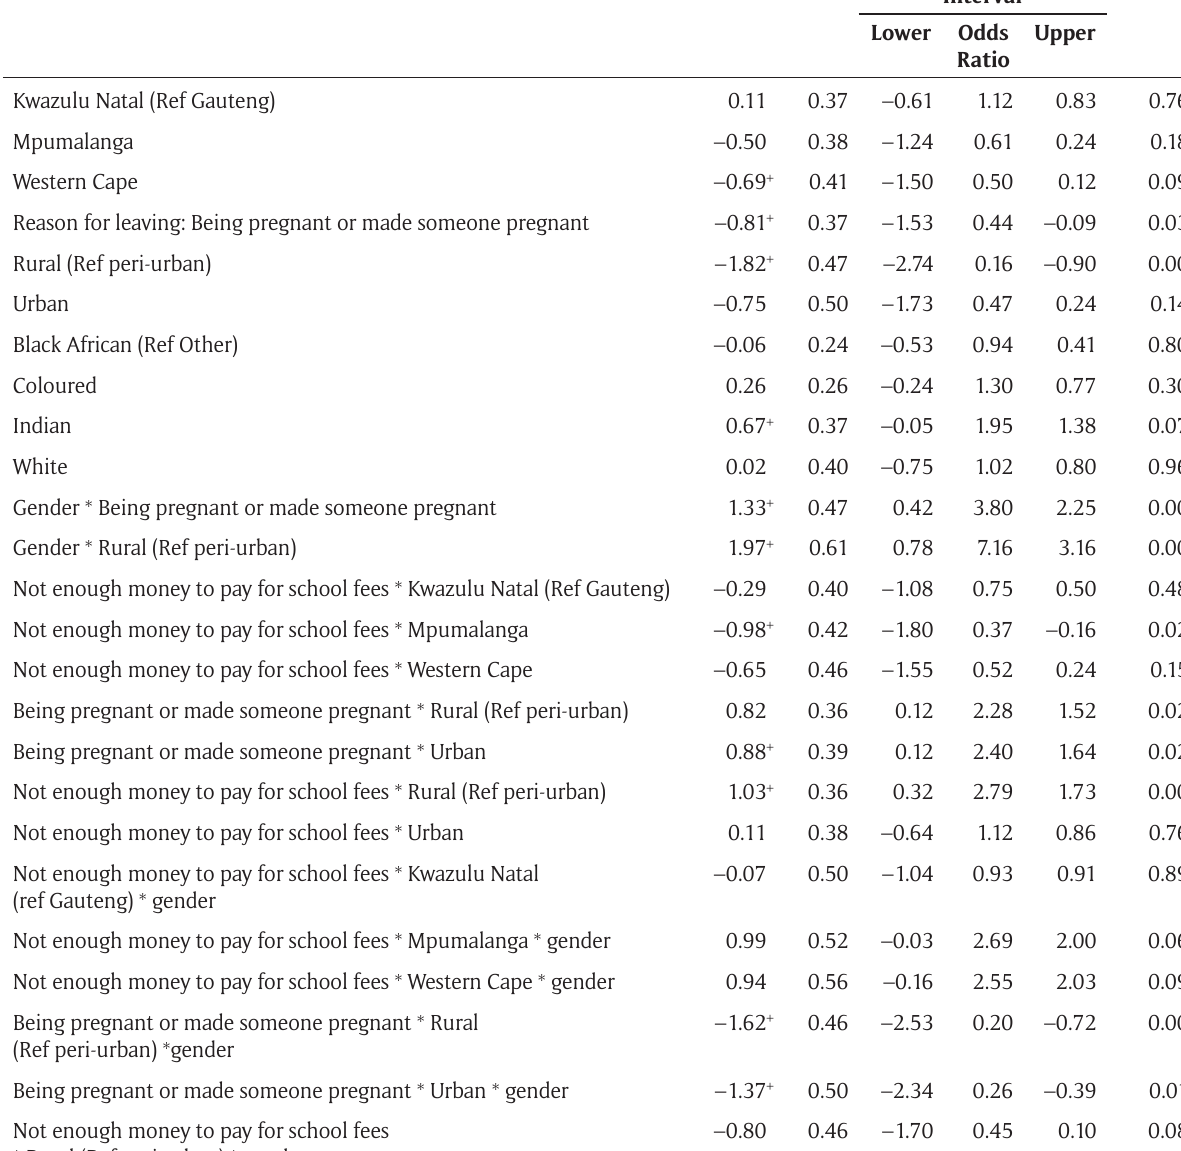
Table 2: Ordinal regression results for the model including interaction terms with province, area, and gender.